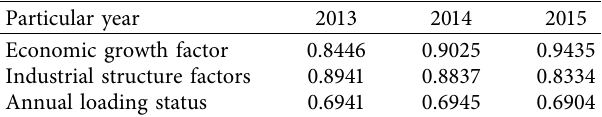
Table 6: Ecocultural bearing status of the economic subsystem of London urban agglomeration [22].